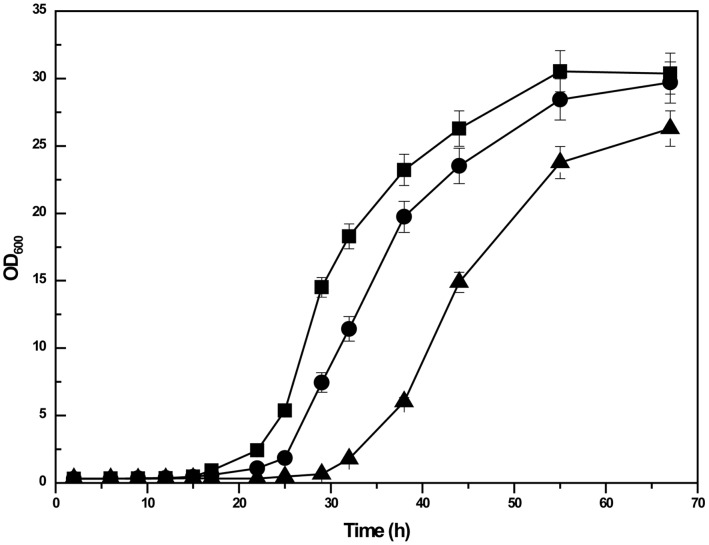
Comparison of cell growth of GS115 (shaded square), GS-tranOCH1-ΔOCH1 (shaded circle), and GS-ΔOCH1 (shaded triangle).Biological triplicate cultures of all three P. pastoris strains are grown at 30°C with 200 rpm shaking in 50 ml Falcon tubes containing 5 ml of YPD medium. Turbidity is monitored at OD600.